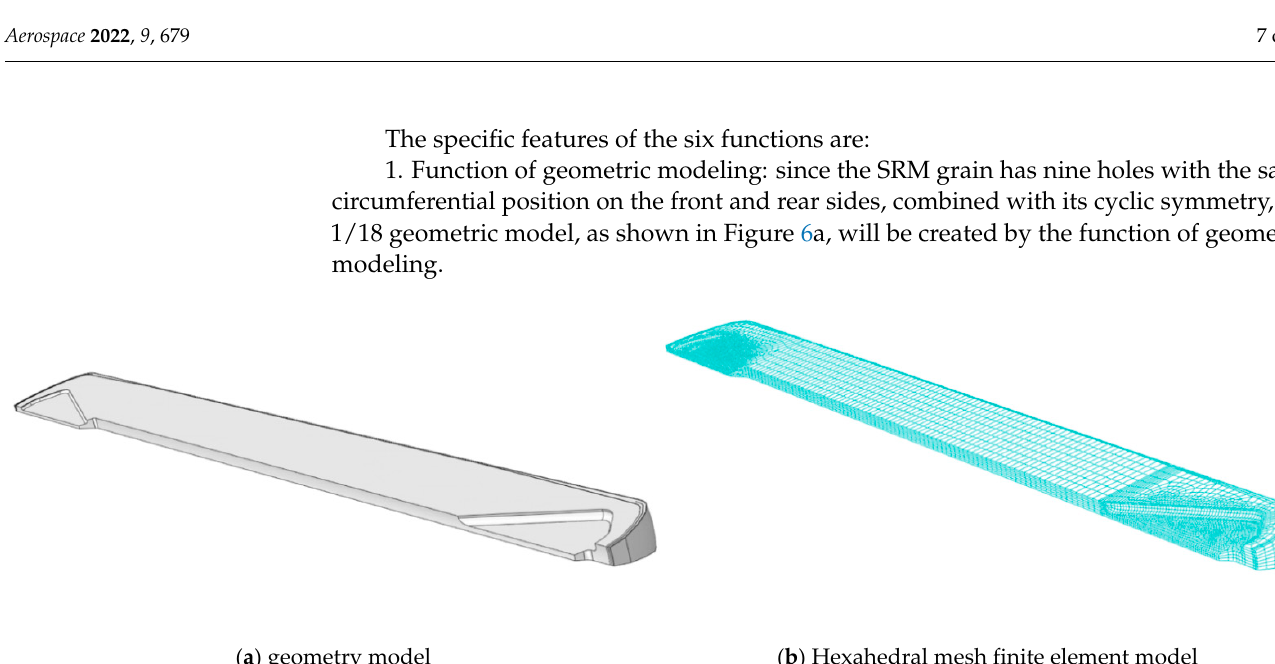
Figure 5. Flowchart for parametric modeling of SRM based on Python functions.